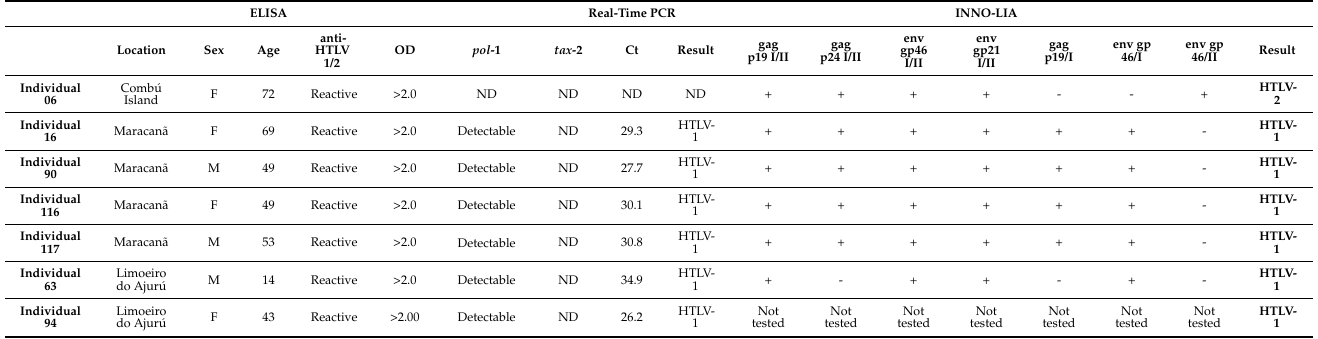
Table 1. Demographic data of HTLV-1 positive patients and results of tests performed to confirm the diagnosis of HTLV 1/2 infection.